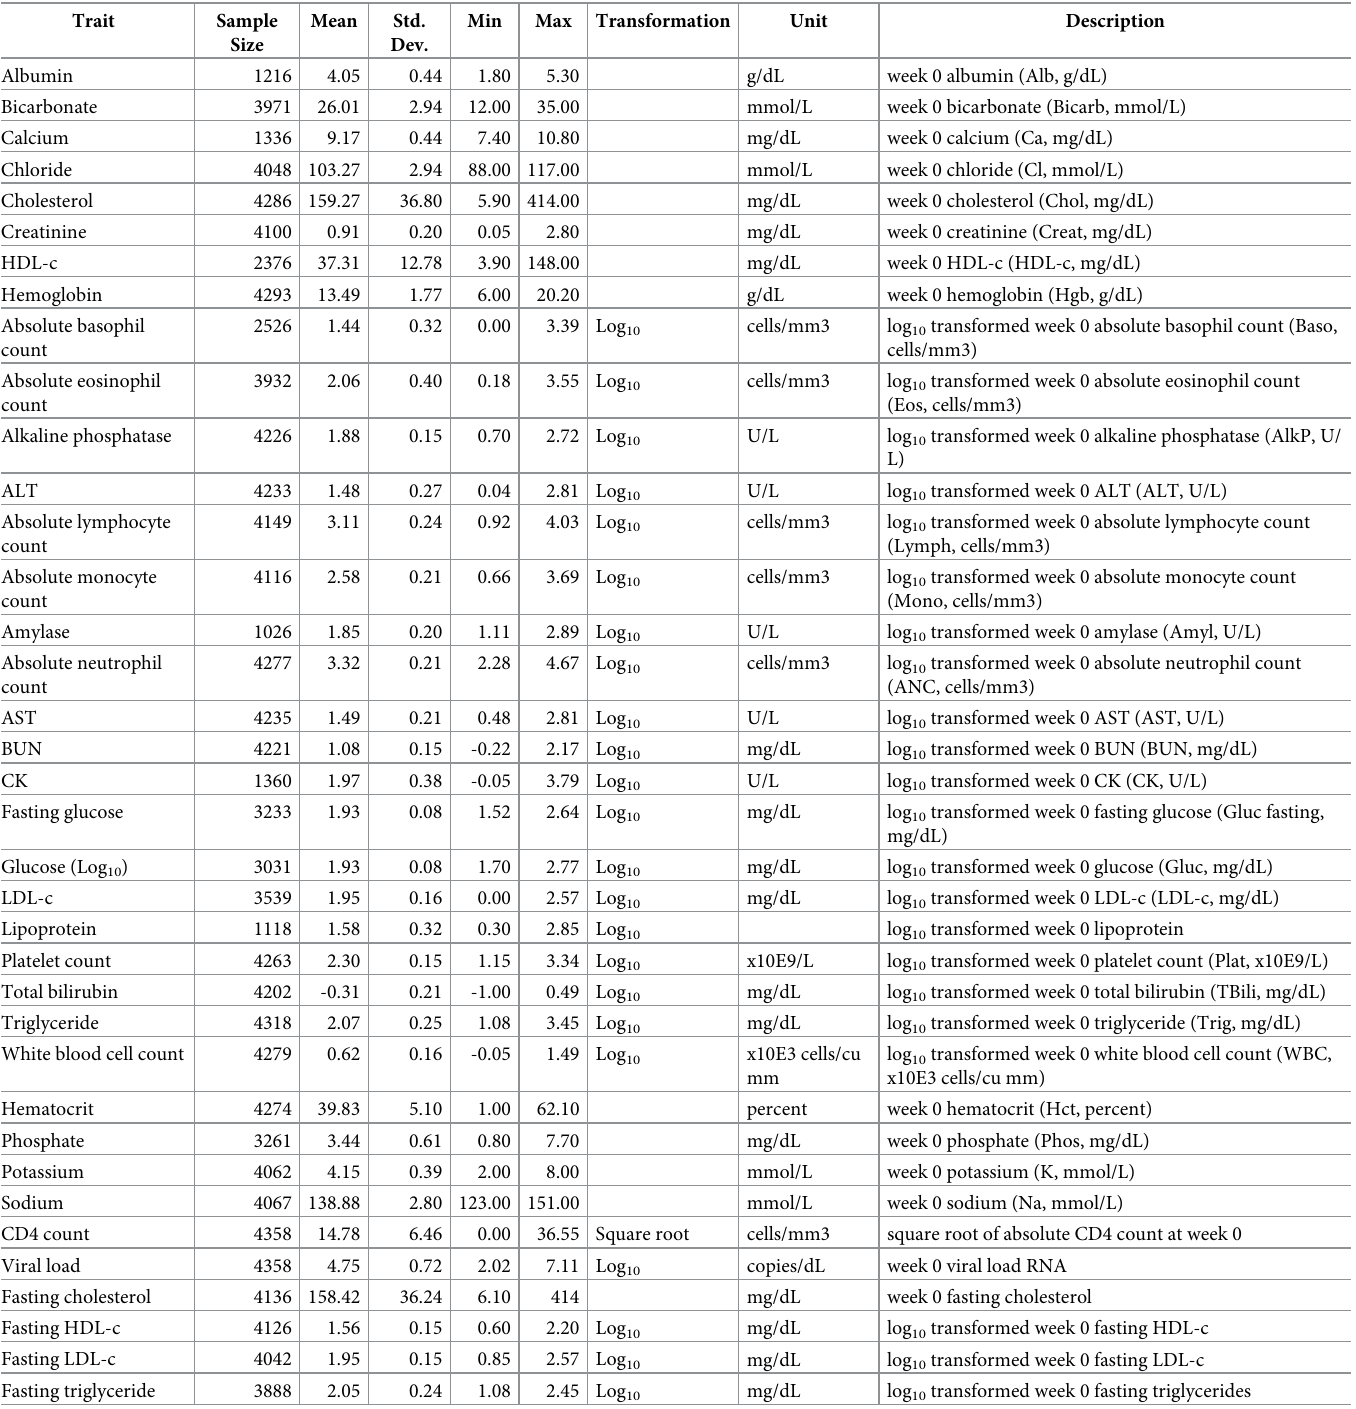
Table 2. Summary statistics of the ACTG genotyping phase I-IV baseline laboratories.